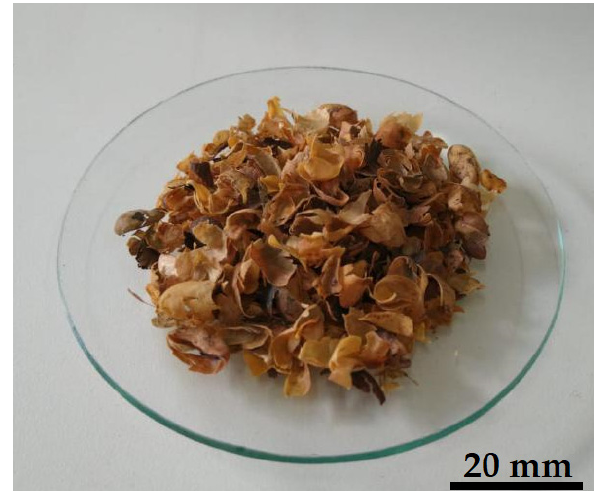
Figure 1. Coffee husk fiber waste (CHFW).